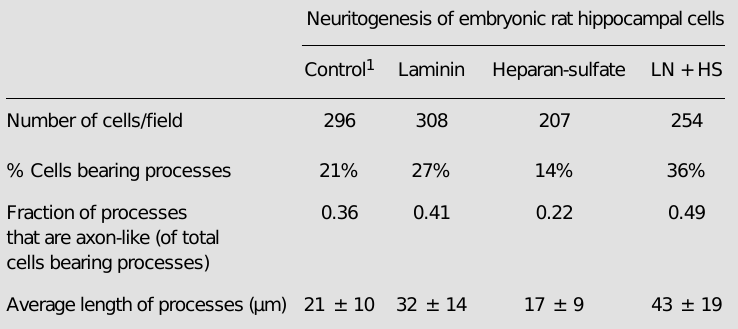
Table 1 - Morphometric analysis of hippocampal cells. 1 Hippocampal cells in primary cultures were plated onto culture dishes and incubated under substrate control conditions, or in the presence of either ECM element. LN, Laminin, HS, heparan sulfate.